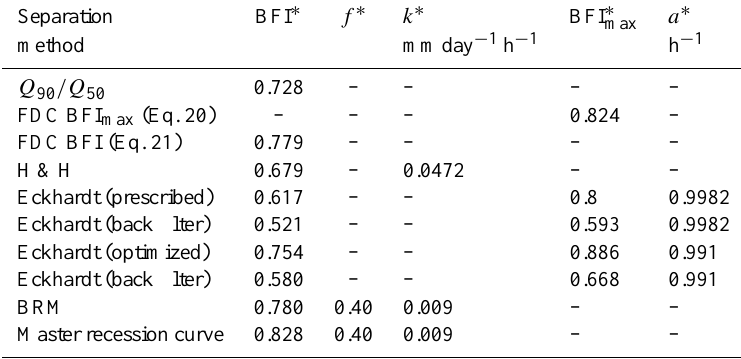
Table 2. BFIs and parameters of the baseflow separation methods applied to the hourly streamflow record in 1996, and to the master recession curve. The Q 90 /Q 50 ratio is from the flow duration curve for 1996, and the FDC BFI max and FDC BFI are from Eqs. (20) and (21) in the text.